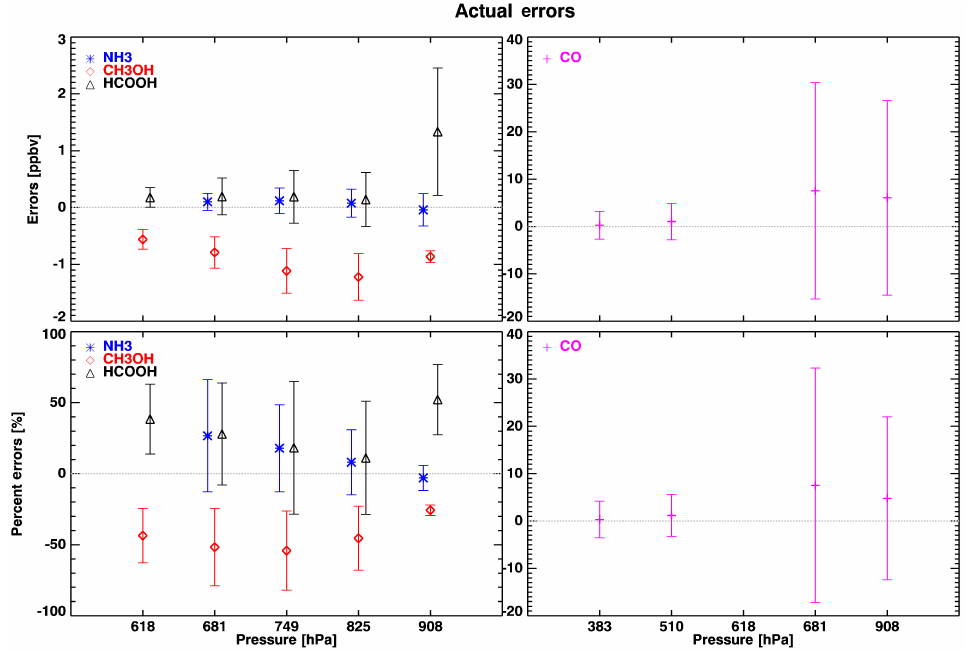
Figure 11. Summary plot of the actual errors (TES/aircraft) from the JOSM comparisons plotted as a function of pressure for NH 3 , CH 3 OH, HCOOH, and CO.